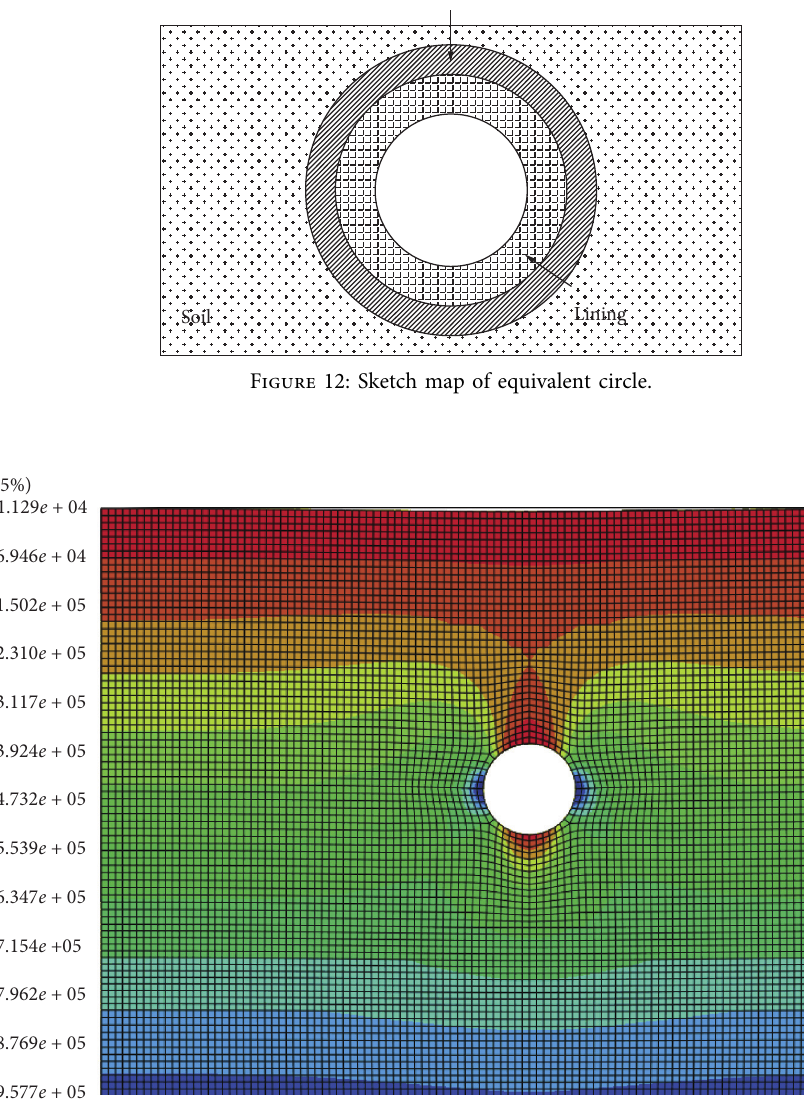
Figure 13: Vertical stress distribution of surrounding rock (Pa).